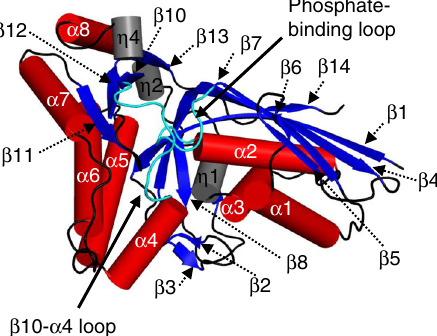
Fig. 1 MDD EF structure. The crystal structure of MDD EF in complex with MVAPP, ADPBeF 3 , and Mg 2 + (MDD EF -MVAPP-ADPBeF 3 -Mg 2 + ) was analyzed by PROMOTIF 61 . Secondary structure elements, α -helices (red cylinders), 3 10 -helices (gray cylinders) and β -sheets (blue arrows) are drawn and labeled as α , η , and β . The β 10- α 4 loop and the phosphate- binding loop are shown in cyan. The range of amino acid numbers of each secondary structural element is listed as following: β 1(1 – 15), β 2(20 – 22), β